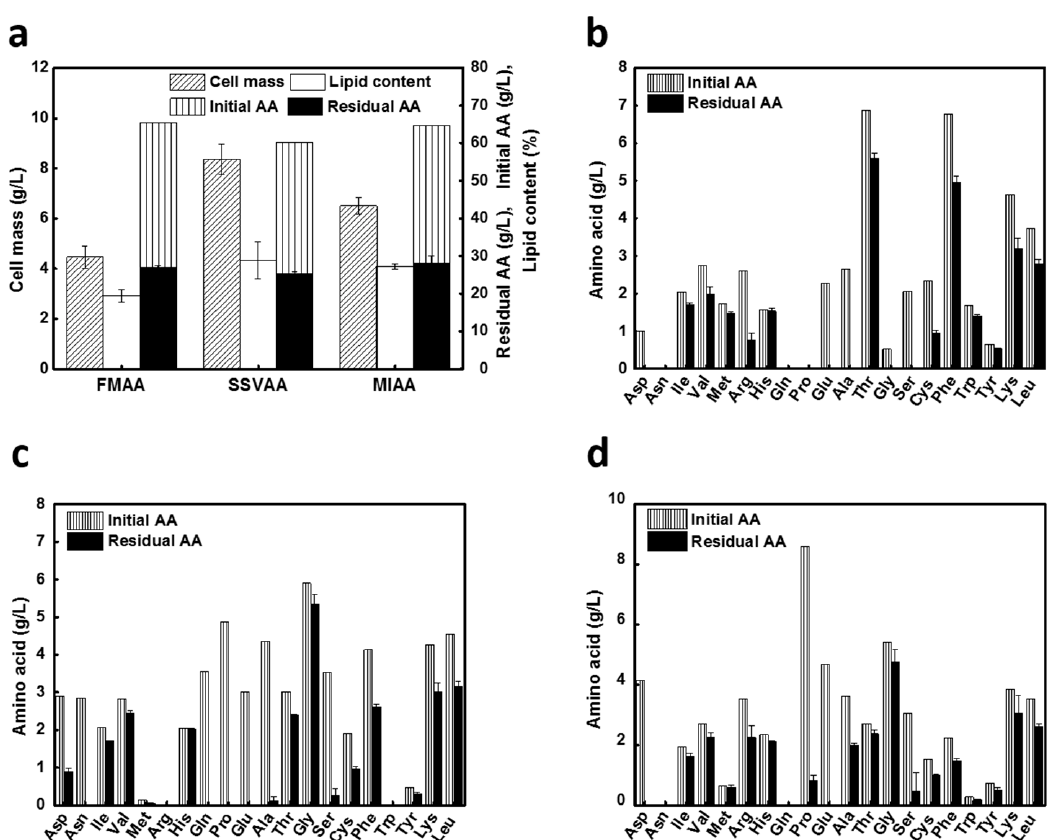
Figure 2. Results of lipid production at 30 °C and 200 rpm for 108 h from AA blends at a total carbon concentration of 28 g / L. ( a ) Lipid production in FMAA, SVAA, and MIAA blends. ( b ) Initial and residual AA profiles of FMAA media blend. ( c ) Initial and residual AA profiles of SVAA media blend. ( d ) Initial and residual AA profiles of MIAA media blend.